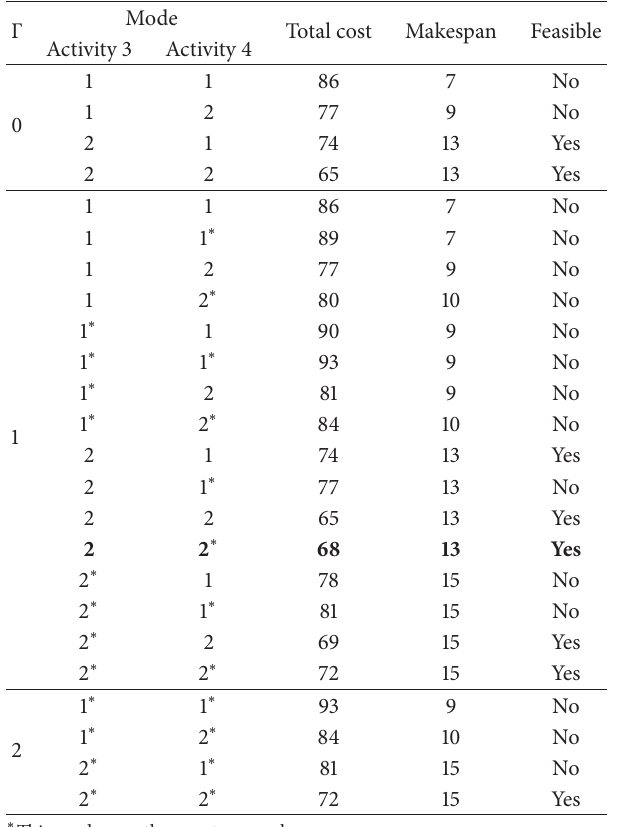
Table 1: Computations for the example problem. Table 2: Parameter